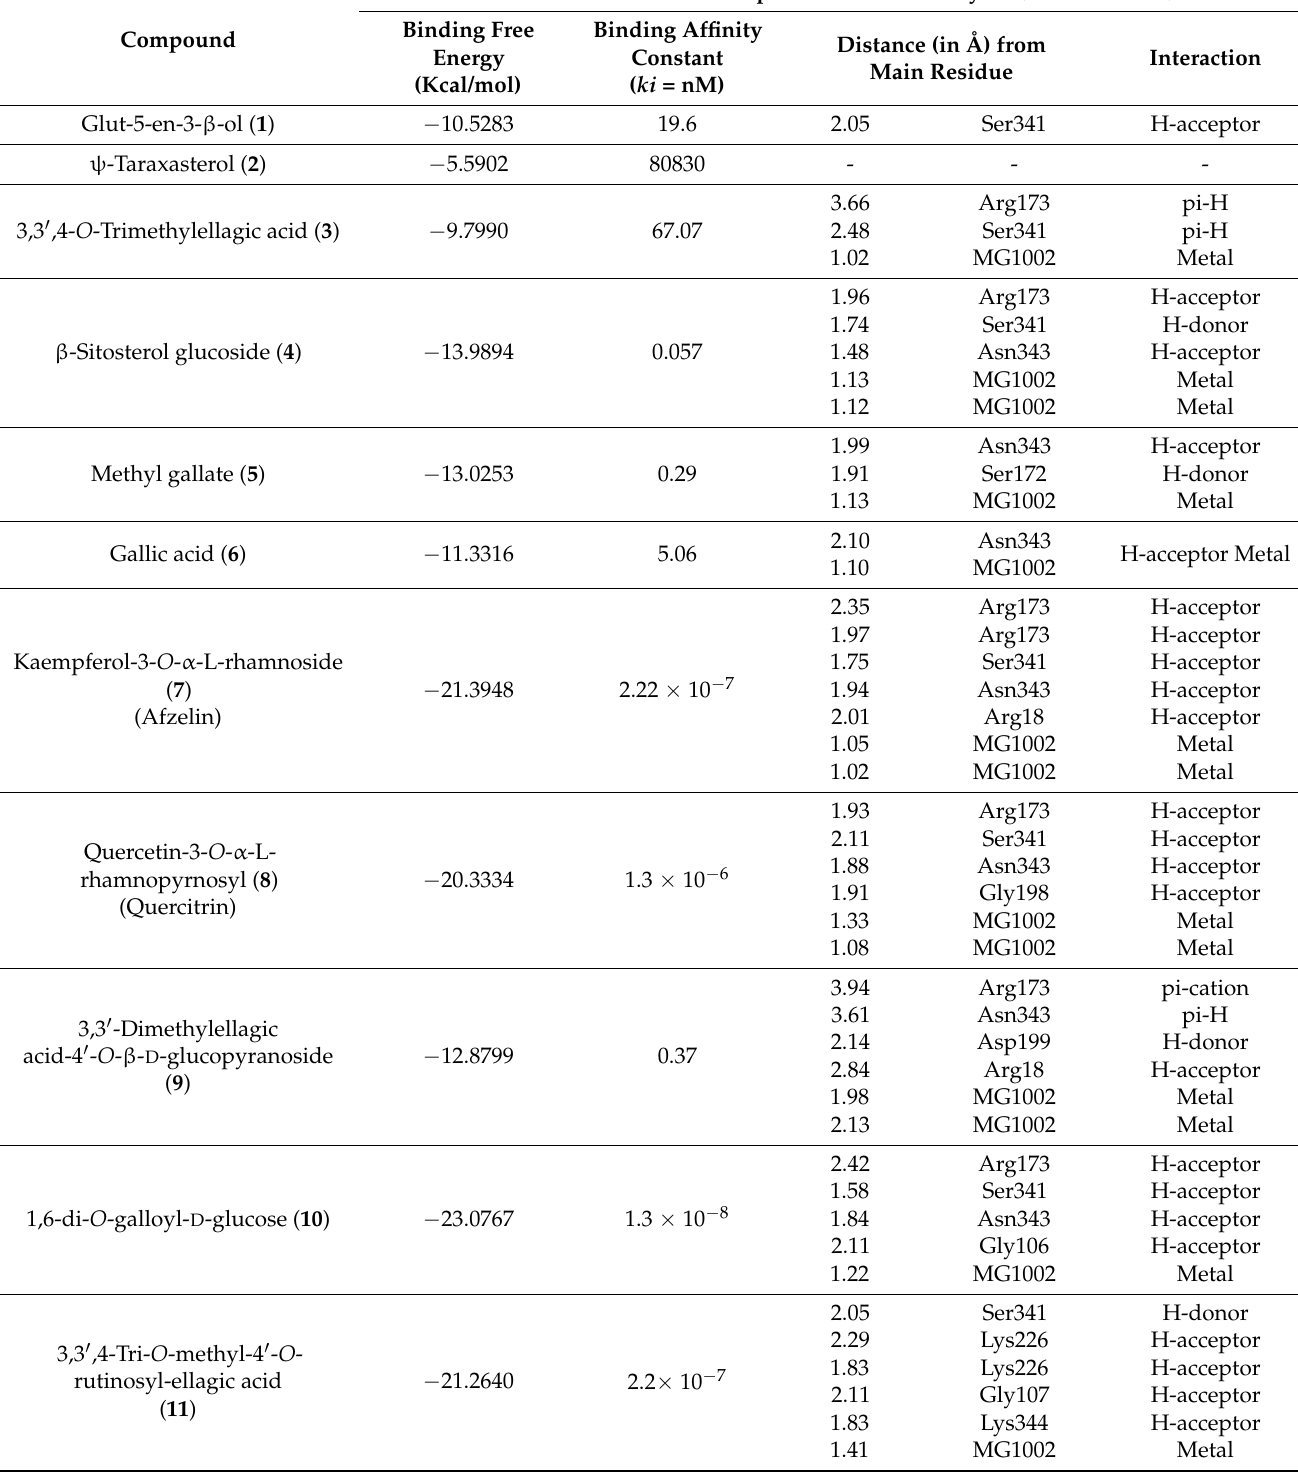
Table 1. Binding energy score of the target isolated twelve compounds and suramin with T.